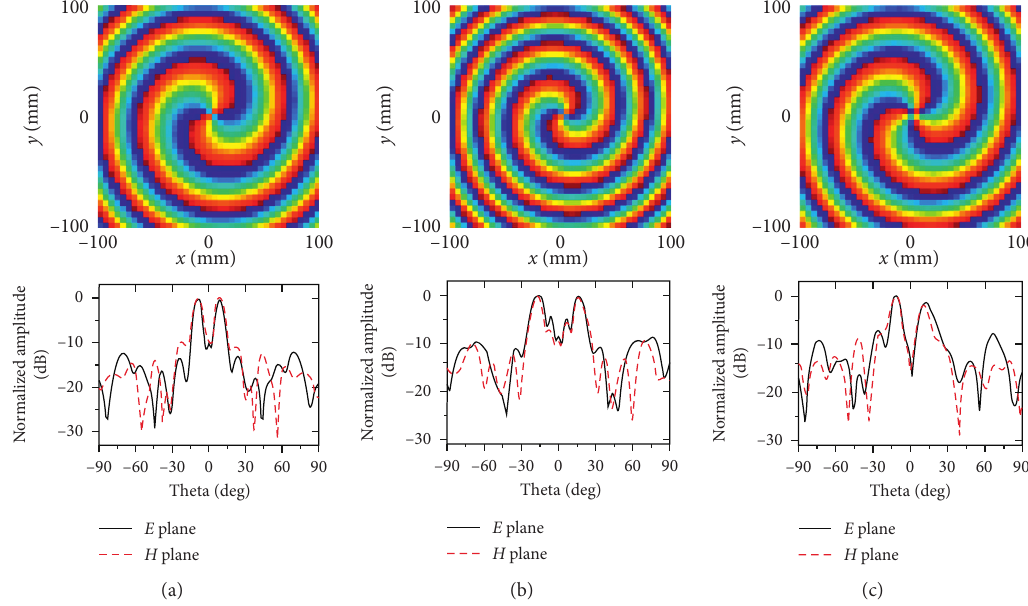
Figure 4: Results for (a) l � 2 and δ the metasurface for generating a conical beam carrying OAM, and the bottom panels show the simulated 2D far-field radiation patterns of the